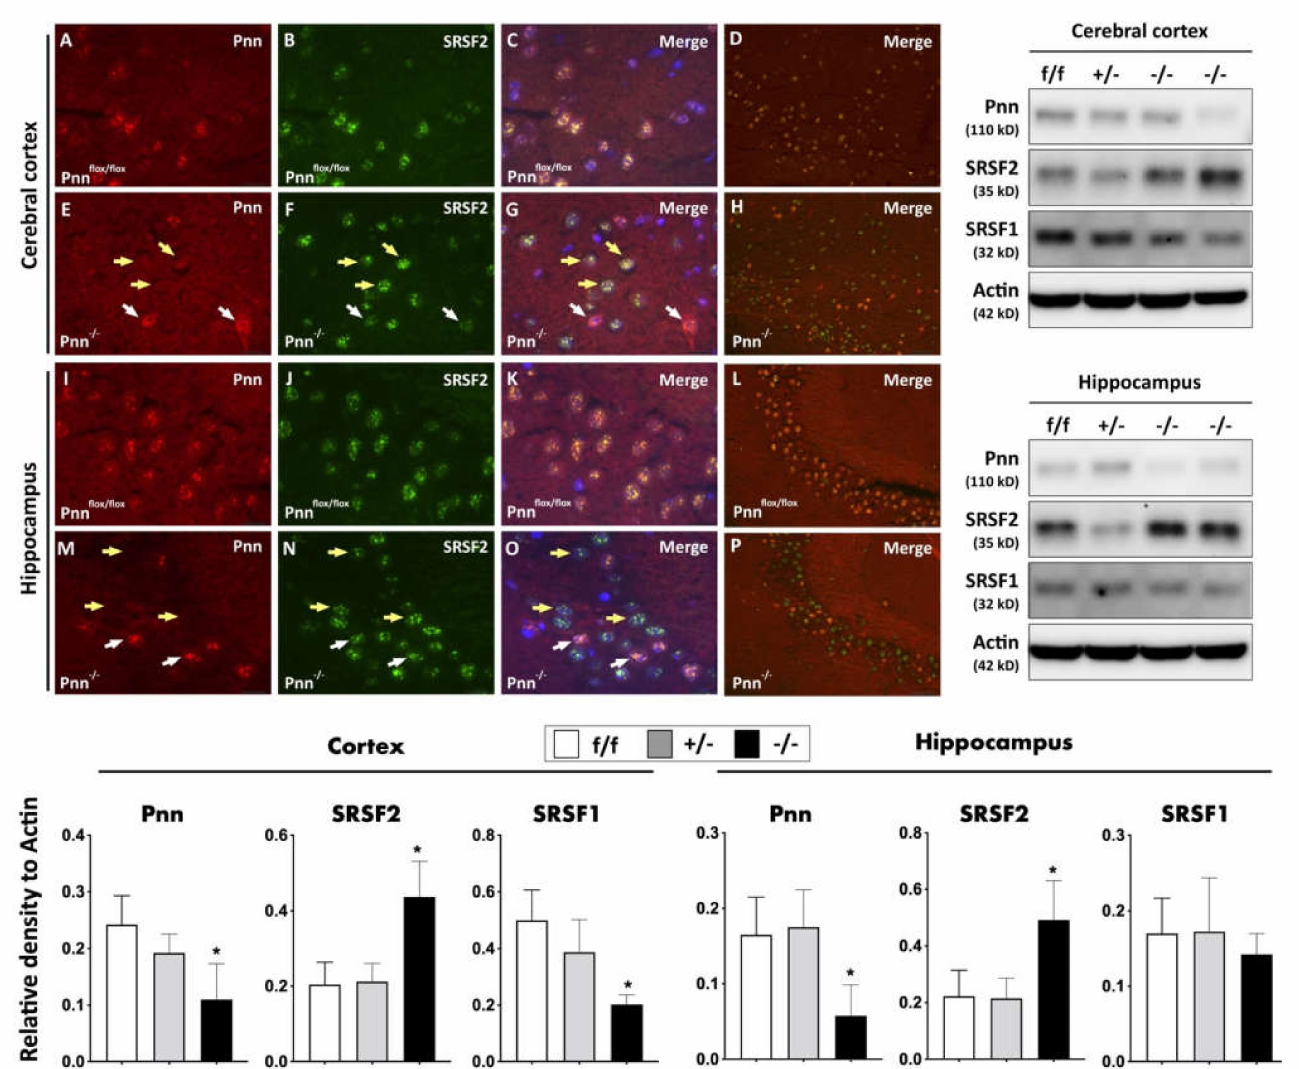
Figure 3. Expression and distribution of splicing regulators in neurons with Pnn depletion. (Upper- left panel) Immunofluorescent staining to examine the expression and distribution of Pnn and splicing regulator SRSF2 in cerebral cortex and hippocampus of mice with or without neuronal Pnn depletion. (Upper-right panel) Western blotting to examine the expression of Pnn, SRSF1, and SRSF2 in cerebral cortex and hippocampus. (Lower panel) Quantitation and comparison of protein expressions of Pnn, SRSF2, and SRSF1 in cerebral cortex and hippocampus. ( A , E , I , M ) Expression of Pnn in cerebral cortex and hippocampus. ( B , F , J , N ) Expression of SRSF2 in cerebral cortex and hippocampus. ( C , G , K , O ) Merged images with DAPI nuclear counter-staining. ( D , H , L , P ) Low-power-field merged images without DAPI staining. Results from immunofluorescent staining further demonstrated the increased expression of SRSF2 in neurons without Pnn expression (yellow arrows), while cells with Pnn expression showed a lower level of SRSF2 expression (white arrows). In Western blotting, results indicated that neuronal Pnn depletion reduced the expression of SRSF1, while the expression level of SRSF2 showed a contrary manner. SRSF1, serine and arginine rich splicing factor 1. SRSF2, serine and arginine rich splicing factor 2. f/f, flox/flox mice. +/-, mice with heterozygous neuronal Pnn deficiency. -/-, mice with homozygous neuronal Pnn deficiency. n = 4 for each group. * indicates significance compared with f/f